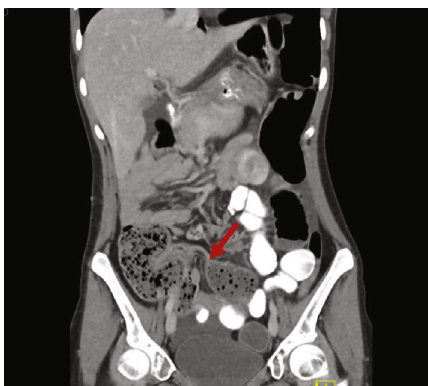
Figure 2: CT of the abdomen and pelvis showing with the red arrow indicating a transition point just proximal to the terminal